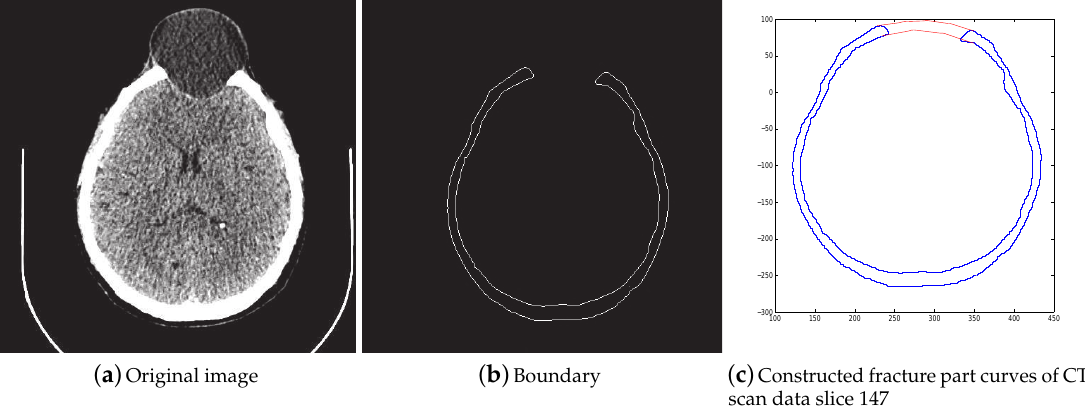
( c ) Constructed fracture part curves of CT scan data slice 147